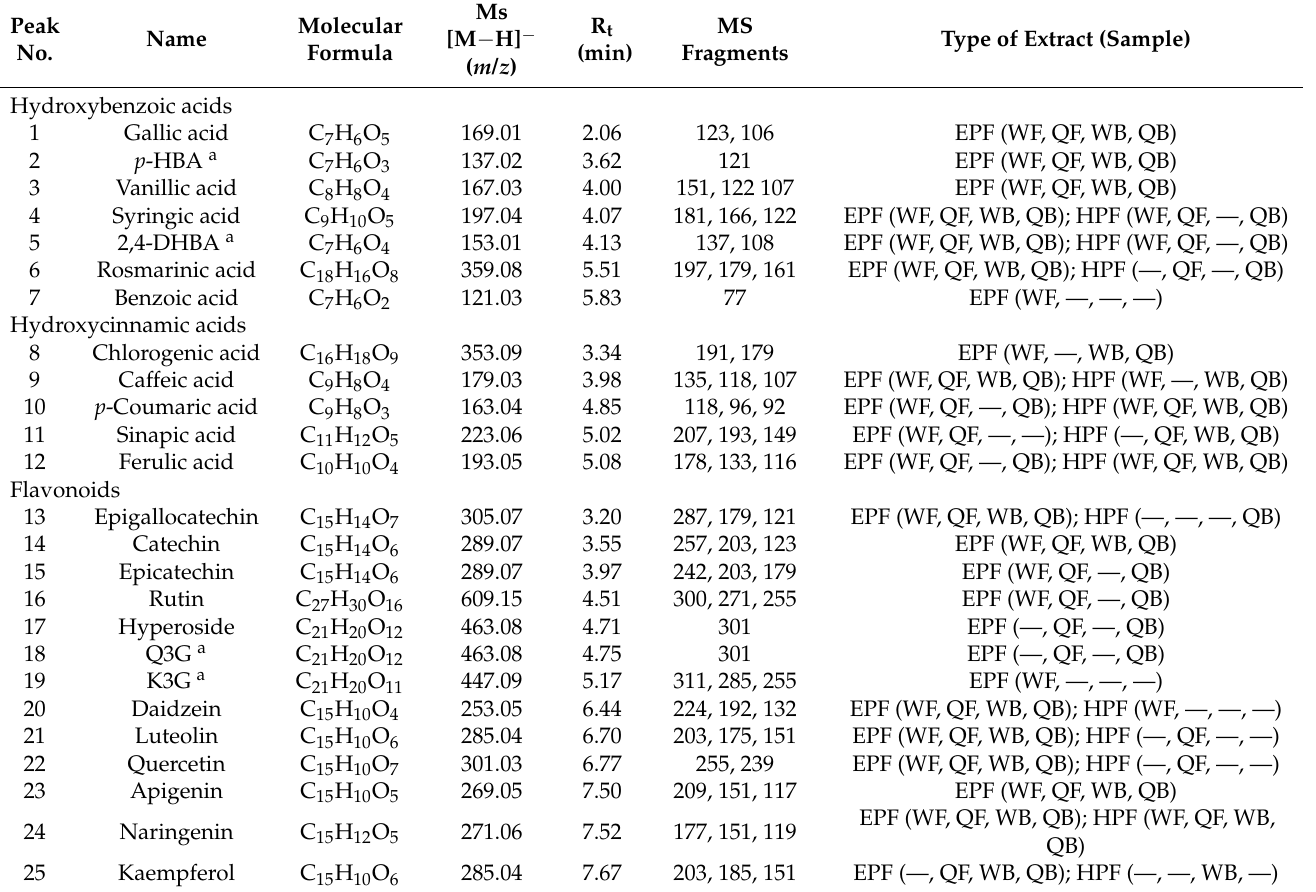
Table 1. Phenolic compounds identified in the extractable (EPF) and hydrolyzable (HPF) fractions of raw materials (wheat flour: WF and quinoa flour: QF) and bread (wheat bread: WB and 25% quinoa bread: